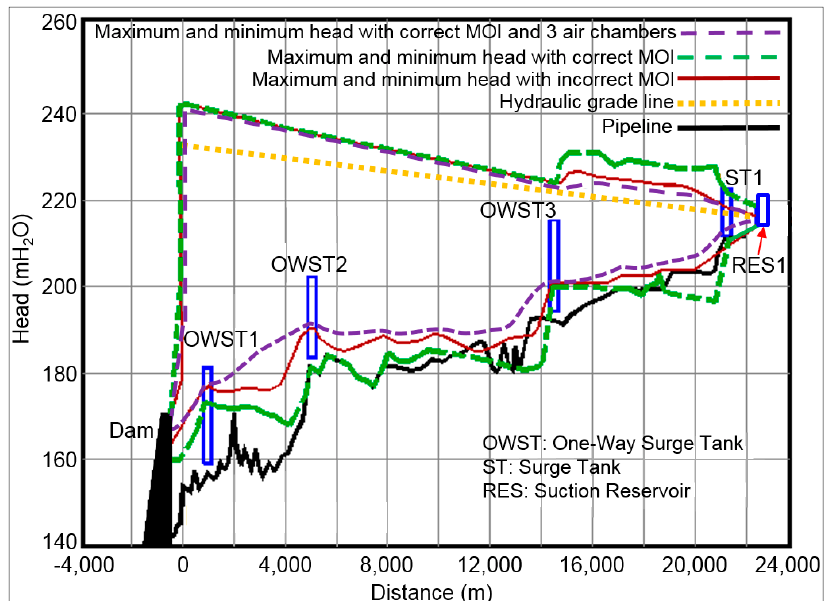
Figure 3. Maximum and minimum head envelopes for the first pipeline segment, considering the incorrect moment of inertia (original design), the correct moment of inertia (MOI), and the correct moment of inertia and the three additional air chambers, following the simultaneous power failure of the five pumps at Pumping Plant 1.